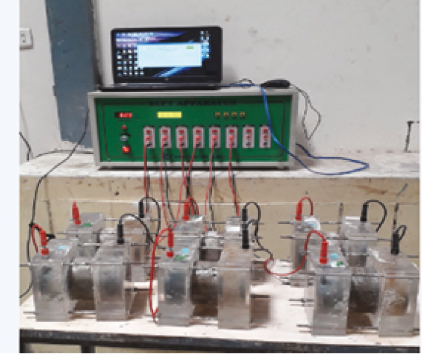
Figure 4: Test setup for RCPT test.